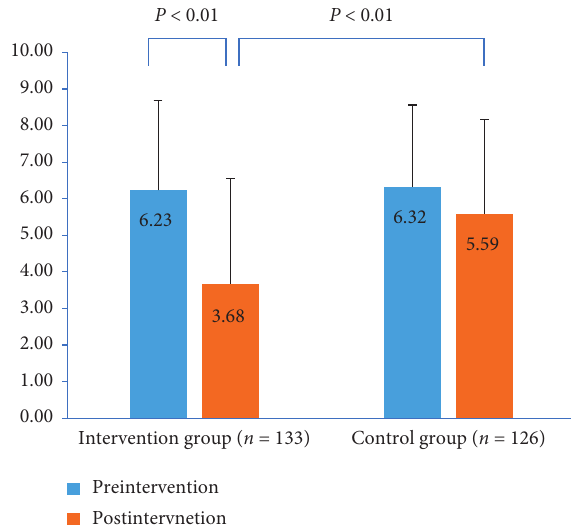
Figure 3: BMQ score in the intervention group and control group pre-and